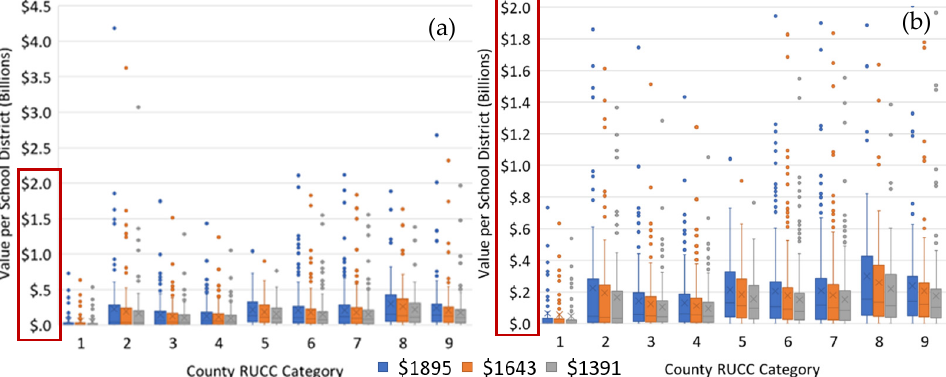
Figure 9. Wind turbine original value installed in different school districts, classified for their county USDA category. ( a ) Full range values in y -axis. ( b ) Limited range values in y -axis to enhance data visibility.